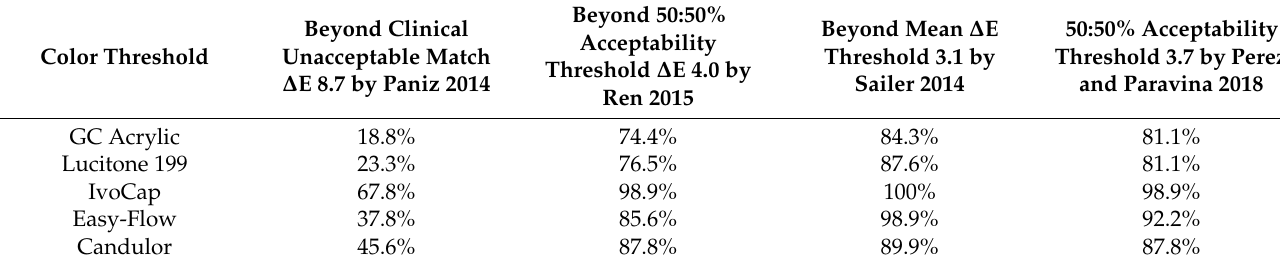
Table 2. The percentage of patients with best match shade tab above the acceptable